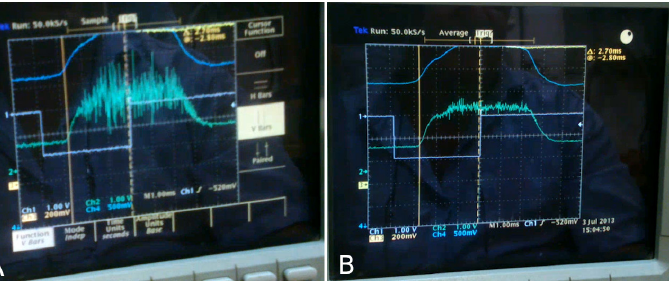
Figure 5. Screenshots of the oscilloscope: the blue trace is the displacement sensor signal while the cyan trace is the fuel injection rate signal. ( A ) the real-time single-shot signals; ( B ) the signals averaged over tens of